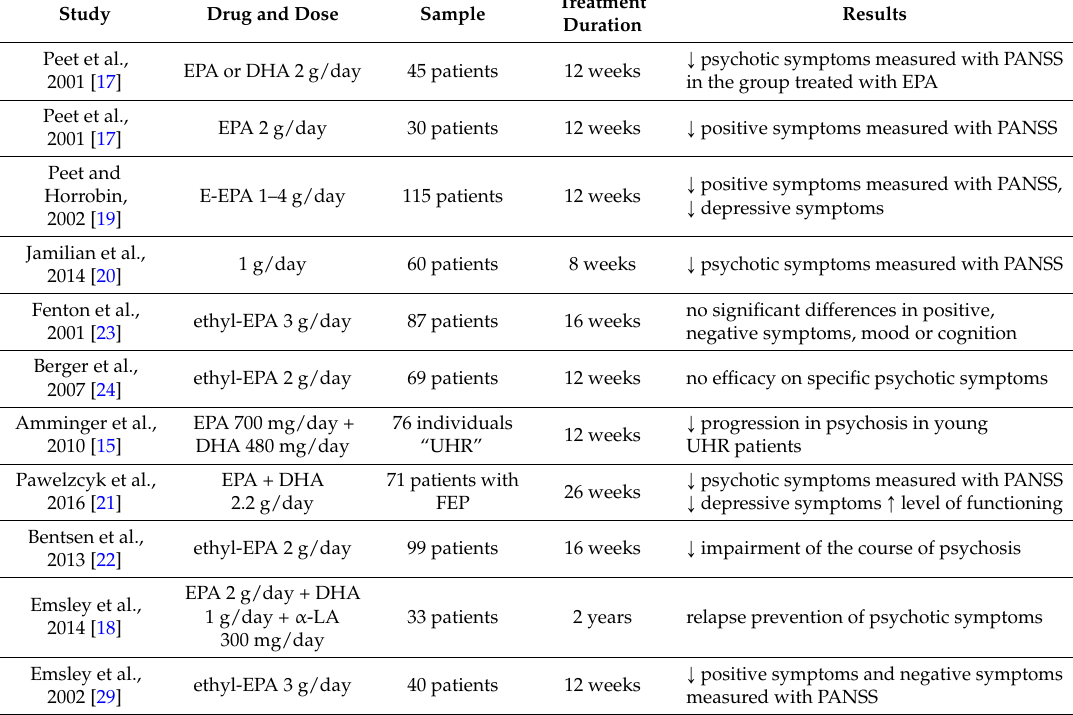
Table 1. Double-blind controlled trials of highly unsaturated fatty acids (HUFAs) as an add-on strategy in the treatment of schizophrenia. PANSS, Positive and Negative Syndrome Scale; E-EPA,